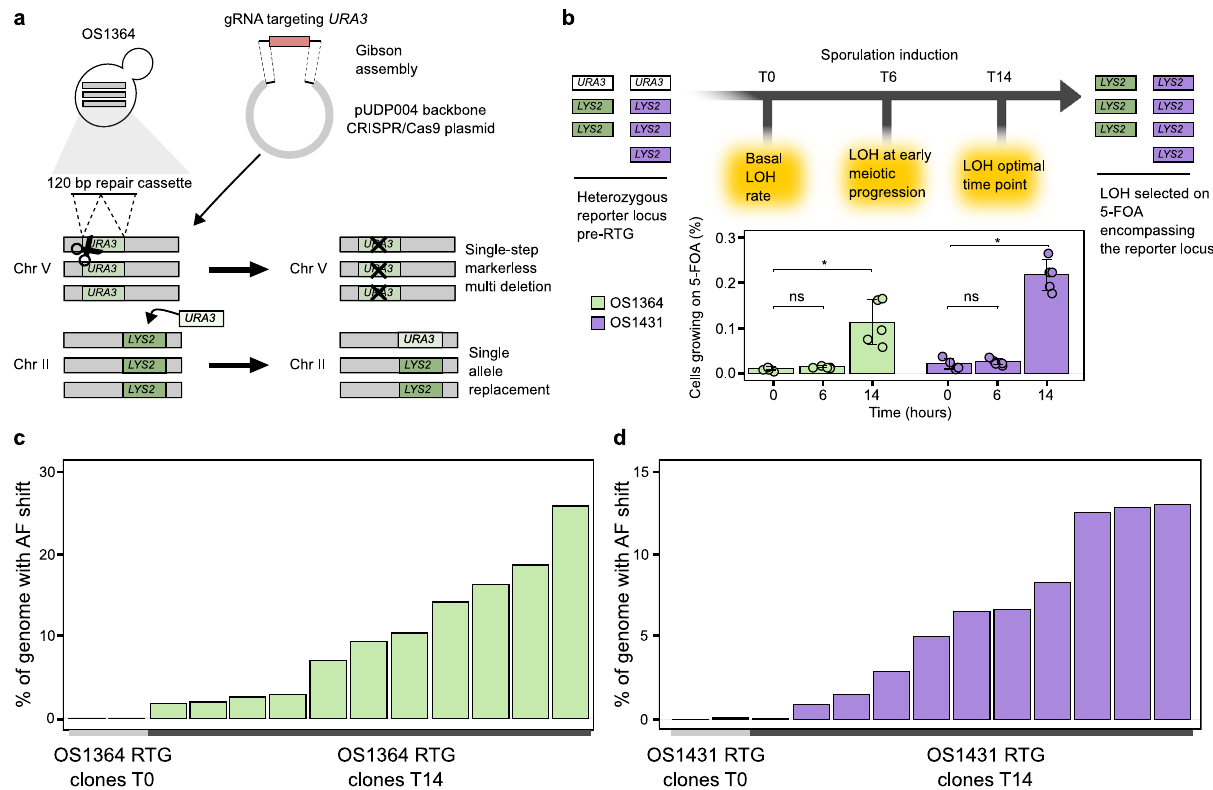
Fig. 2 RTG recombination in sterile polyploids. a A URA3- loss genetic system in the polyploid strains was engineered with a CRISPR-based approach. The strains generated in such way are hereafter referred to as LYS2/URA3 regardless of the number of loci. b The URA3 -loss genetic system was used to measure recombination rate at the heterozygotic locus LYS2/URA3 (top panel). Bar plots representing the average ( n = 5 replicates) percentage of cells growing on 5-FOA at different time points: no sporulation induction (T0), 6 hours (T6) and 14 hours (T14) of sporulation induction (bottom panel). The increase of cells growing on 5-FOA at T14 compared to T0 was signi fi cant for both samples ( p value = 0.006., one-sided Wilcoxon ranked-sum test) whereas was not signi fi cant at T6 ( p -value = 0.06, one-sided Wilcoxon ranked-sum test). The error bars represent the standard deviation. c , d Bar plot representing the percentage of genome in which we detected an allele frequency (AF) shift for the RTG samples selected for URA3 -loss derived from OS1364 LYS2/URA3 (green, c ) and OS1431 LYS2/URA3 (purple, d ). Recombination and LOH induced upon genome engineering with CRISPR/Cas9 at the native URA3 locus was excluded. Source data are provided as a Source Data fi